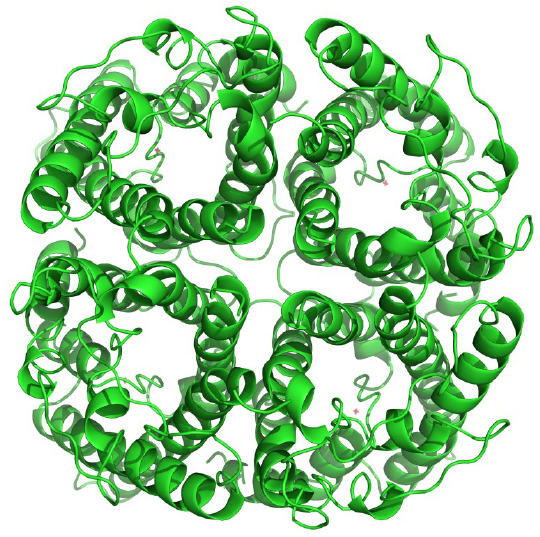
Figure 1. General structure of aquaporins, with a tetrameric arrangement of water channels. This structure is for human